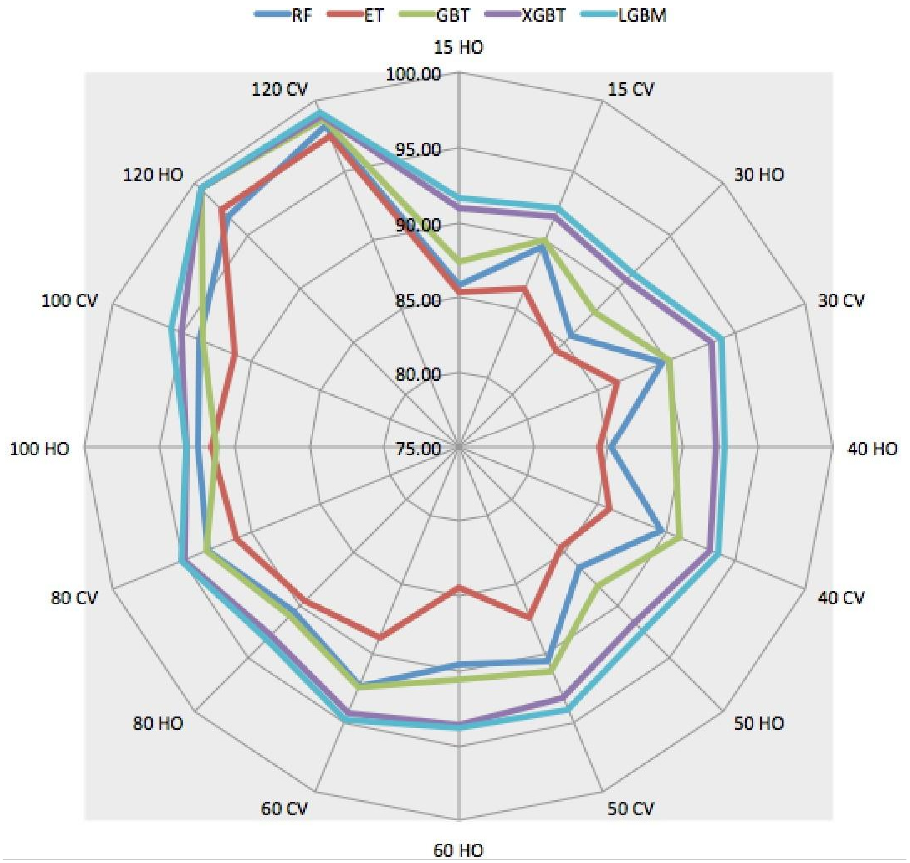
Figure 5. Performance sensitivity analysis of all models in both strategies.